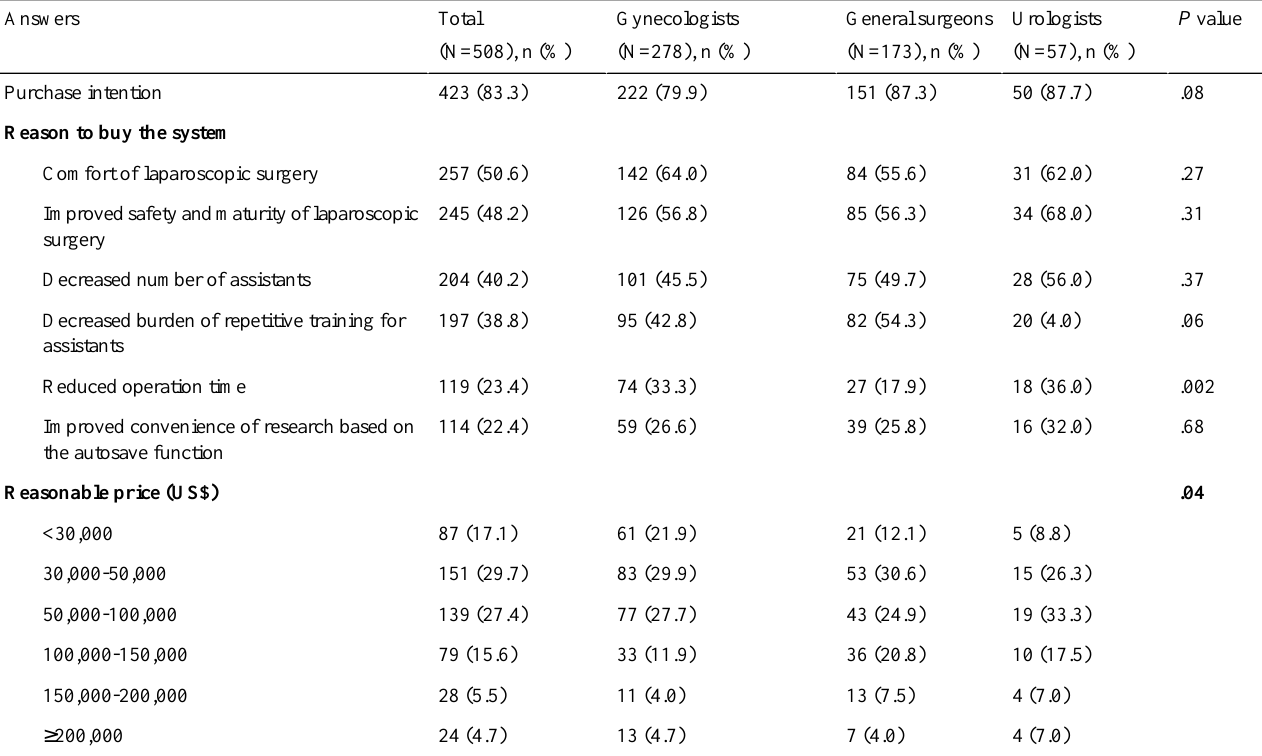
Table 5. Purchase intention and reasonable price to buy the artificial intelligence–based surgical assistant